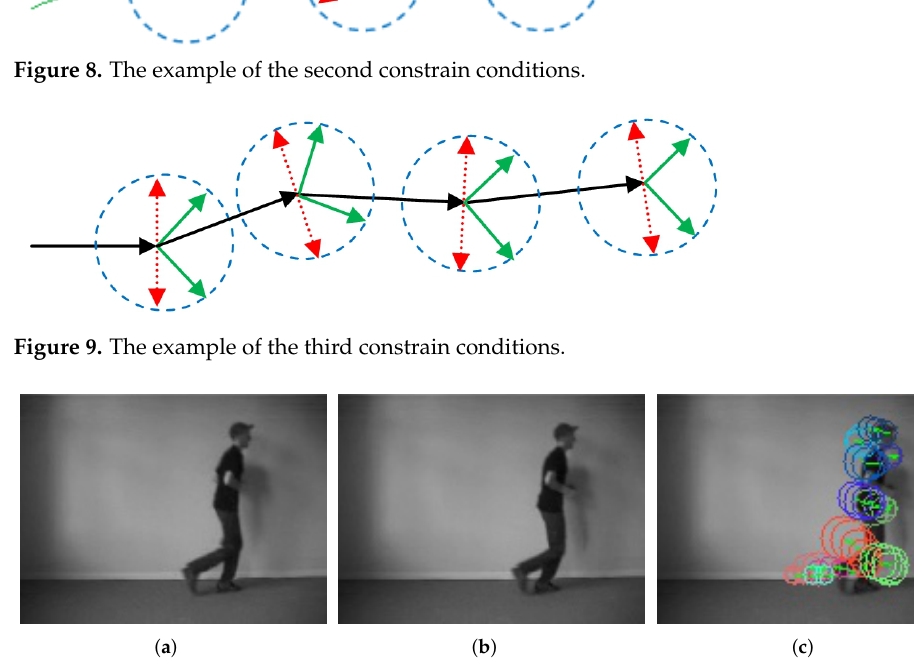
Figure 10. Illustration of SURF trajectory. ( a ) The former frame. ( b ) The next frame. ( c ) Motion captured by SURF